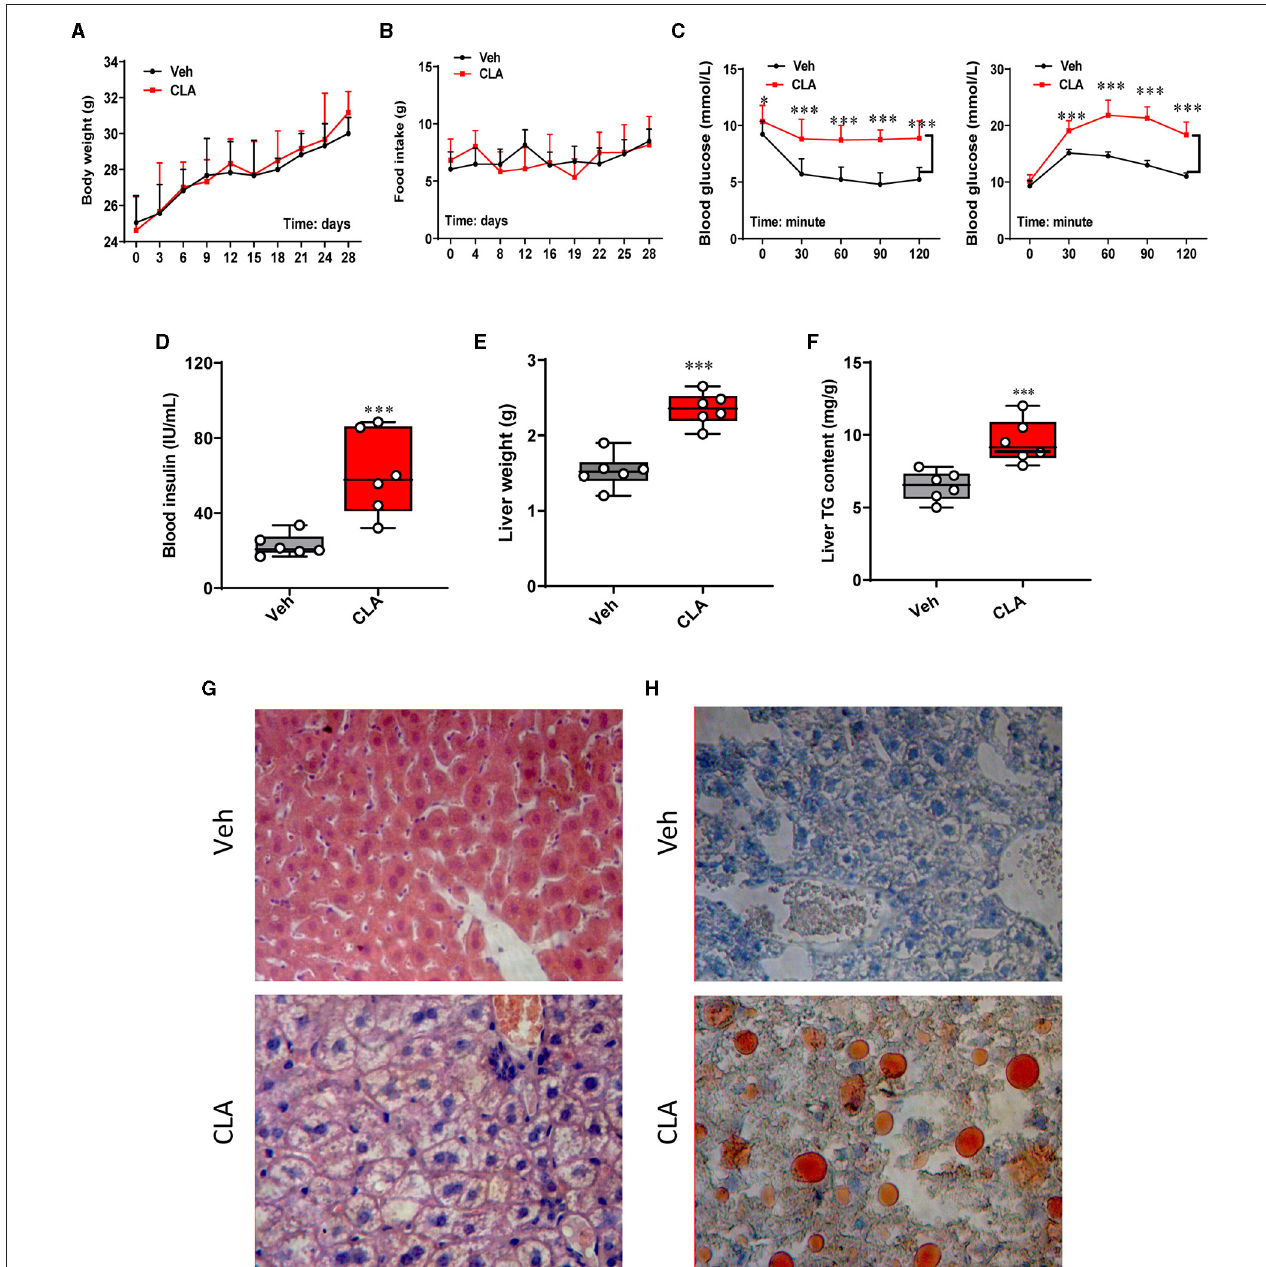
FIGURE 1 | Dietary CLA induces hepatic steatosis in mice. (A) Mice were fed either with a control diet/Vehicle or a diet with 1.5% (w/w) CLA supplementation for 28 days, during which the body weight and food intake (B) were measured. (C) Blood glucose (mmol L-1) following insulin or glucose tolerance test at 0, 30, 60, 90, and 120min posterior to intraperitoneal injection ( i.p. ) injection of insulin. (D) Blood insulin (IU ml-1) levels were measured. (E) Liver weight (g) and (F) liver total triglycerides content (mg g − 1 ). (G) Representative images of the liver sections stained with H&E. (H) Representative images of the liver sections stained with Oil Red O showing increased lipid deposition in CLA-treated mice. Duplicate slides per animal were analyzed. The data are shown as the means ± SEM, n = 6, * p < 0.05, *** p < 0.001 using two-tailed student’s t -test. in the CLA-treated mice compared to the control, including whether the CLA-treatment impairs the liver circadian clock NR1D1 , Clock , Cry1 , Arntl, and Per2 ( Figure 2F ). In contrast, genes rhythmicity, we studied the temporal gene expression in the primary negative transcription factor of the circadian the livers of mice, collected at each indicated zeitgeber time (ZT) clock NR REV-ERB α ( Nr1d1 ) was significantly upregulated at (sampled every 4 h) under a 12-h light/dark cycle. The majority of both the transcription and translation levels ( Figures 2G–I ). the measured hepatic circadian clock genes lost their rhythmicity